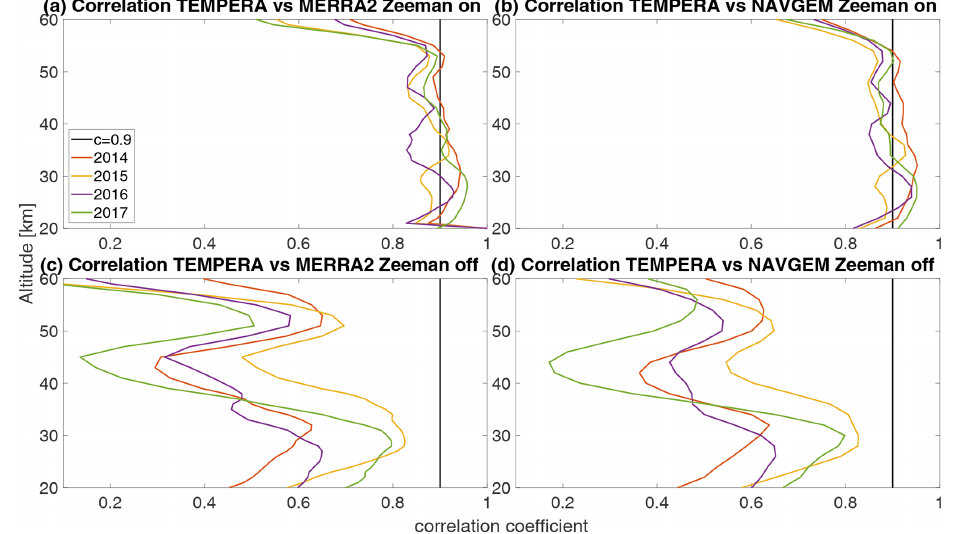
Figure 8. Correlation coefficients over altitude between TEMPERA and MERRA2 data (a, c) , and TEMPERA and NAVGEM-HA (b, d) data. Calculations were performed with activated Zeeman effect (a, b) and deactivated Zeeman effect but with the full line center included (c, d)